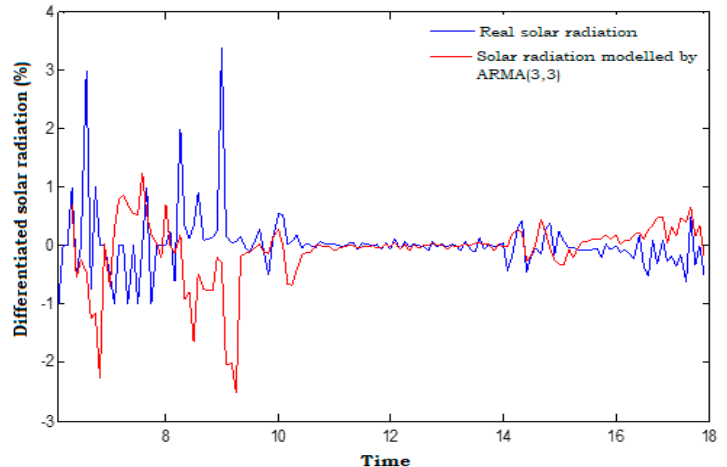
Table 1. Parameters of the ARMA model (winter day).